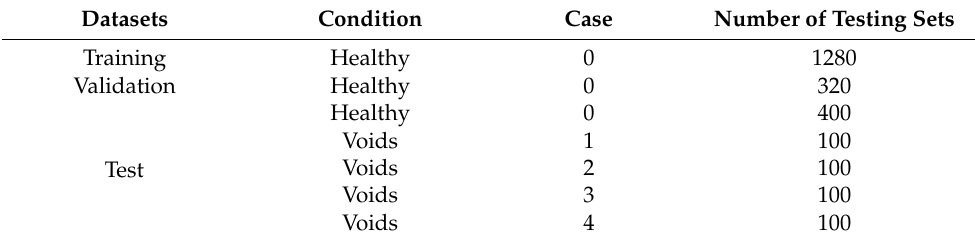
Table 3. Datasets partition.